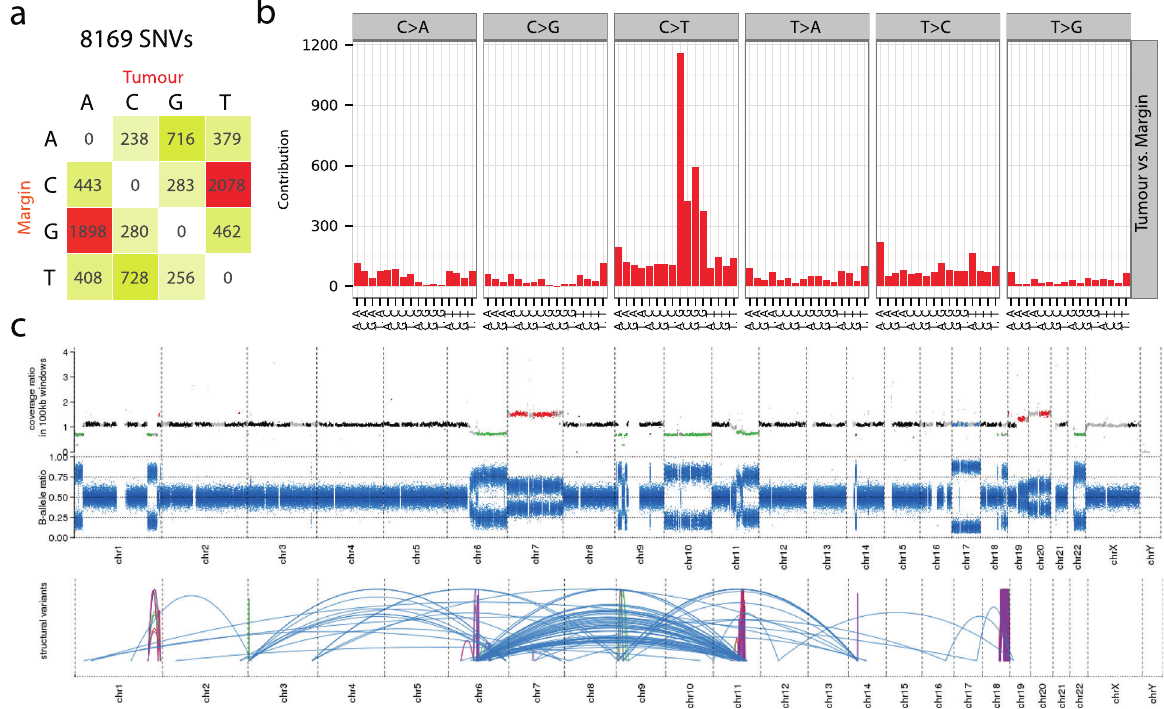
Fig. 3 Genetic variation landscape of the tumour sample. a 8169 somatic variants, mostly C to T transitions, identi fi ed when comparing the tumour and margin samples. b The 5 ′ and 3 ′ nucleotide context around the somatic variants in tumour suggests that most mutations occur in CpG sites. c At the top, genomic location of CNVs: polyploid regions (Gain) in red , diploid regions (Ref) in black , haploid regions (Loss) in green , and loss of heterozygosity (LOH) in blue . In the middle, B-allele ratio plot. At the bottom, genomic translocations ( blue ) and inversions ( purple ) in the